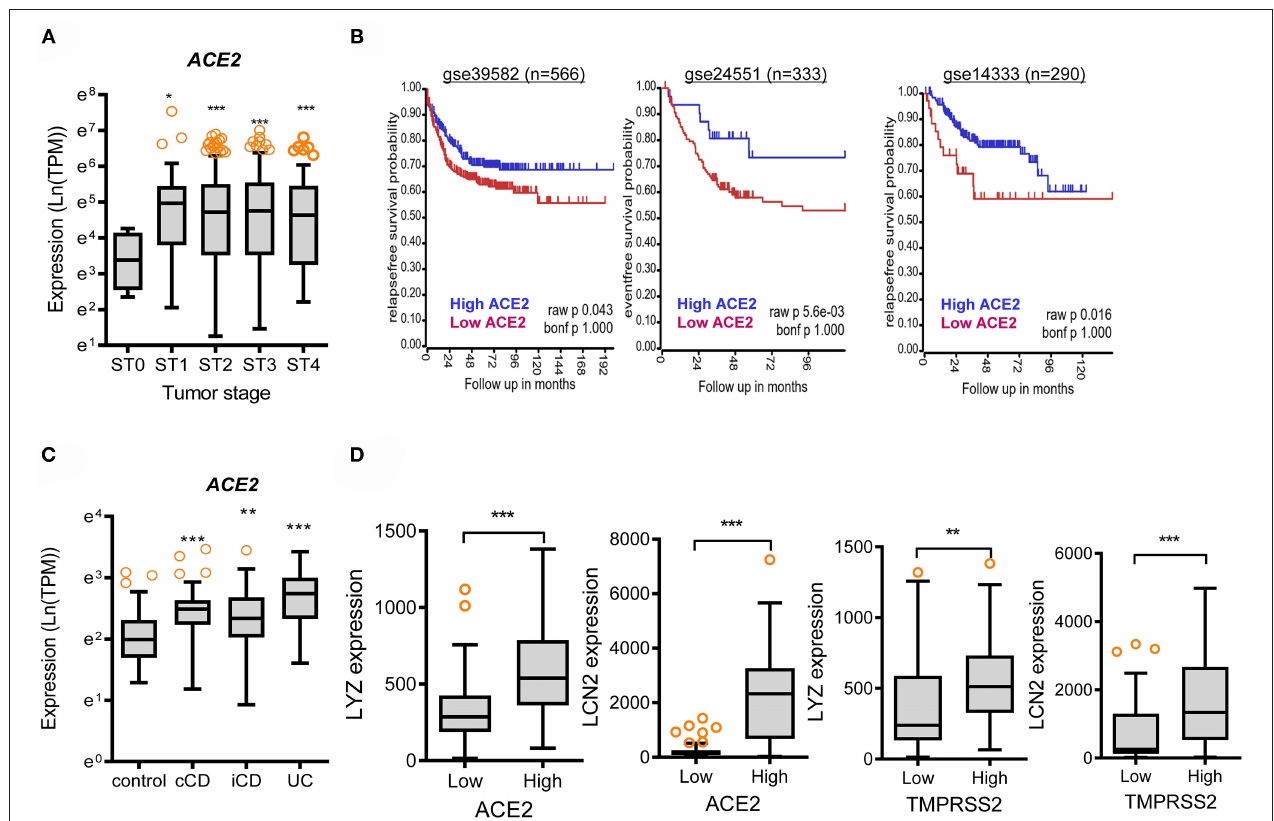
FIGURE 3 | Involvement of SARS-CoV-2 receptors in chronic intestinal diseases. (A) ACE2 expression in different tumor stages from the transcriptome dataset in patients with colon cancer (GEO ID: gse39582, n = 566). Values are presented as natural logarithm of transcripts per million (TPM). Asterisks (*) indicate significant differences from levels at Stage 0 (* p < 0.05, ** p < 0.01, *** p < 0.001 using two-tailed unpaired Student’s t- test). (B) Kaplan–Meier plot of survival analysis based on tissue ACE2 transcript levels in patients with CRC from three datasets (gse39582 [ n = 566, expression cutoff 150.5], gse24551 [ n = 333, expression cutoff 444.6], and gse14333 [ n = 290, expression cutoff 44.5]). (C) Intestinal expression of ACE2 was compared in patients with different IBD types from datasets gse117993 ( n = 190). UC, ulcerative colitis; cCD, colon-only CD; iCD, ileocolonic CD. Values are presented as natural logarithm of transcripts per million (TPM). Results are depicted as box-and-whisker plots (Turkey). Asterisks (*) indicate significant differences from the control group (* p < 0.05, ** p < 0.01, *** p < 0.001 using two-tailed unpaired Student’s t- test). (D) Based on ACE2 or TMPRSS2 levels from datasets gse117993 ( n = 190), we selected the 150 highest and 150 lowest level samples, which were further evaluated based on LYZ and LCN2 levels. Values are presented as natural logarithm of TPM. Asterisks (*) indicate significant differences from the low expression group (* p < 0.05, ** p < 0.01, *** p <